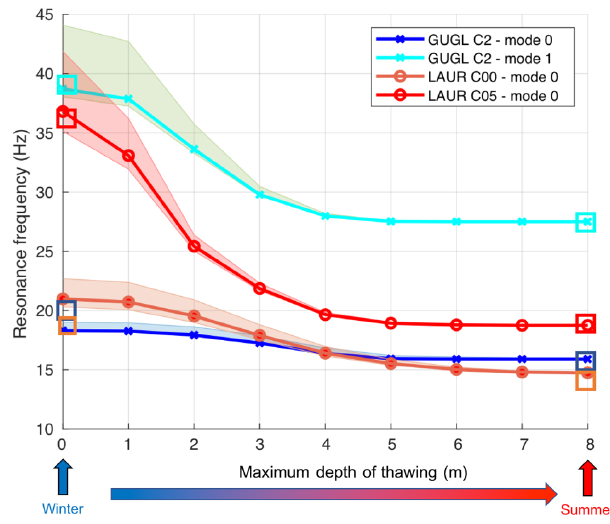
Figure 10. Results of the modal analysis for Gugla (GUGL) and Laurichard (LAUR) rock glaciers. The evolution of the resonance frequency of the respective synthetic modes is plotted, according to the maximal depth of thawing from the surface to the ZAA (8m depth): left stands for the state of maximal freezing in win- ter (frozen medium until 8m depth) and right for the summer (un- frozen medium). The range of measured resonance frequency val- ues is shown by the squares in the corresponding colors (estimated from Figs. 3 and 4 for respective sites). Error bars (in transparent shading) show the influence of porosity on the results: the low (high) limit of error bars shows the results for extremely low (extremely high) porosity